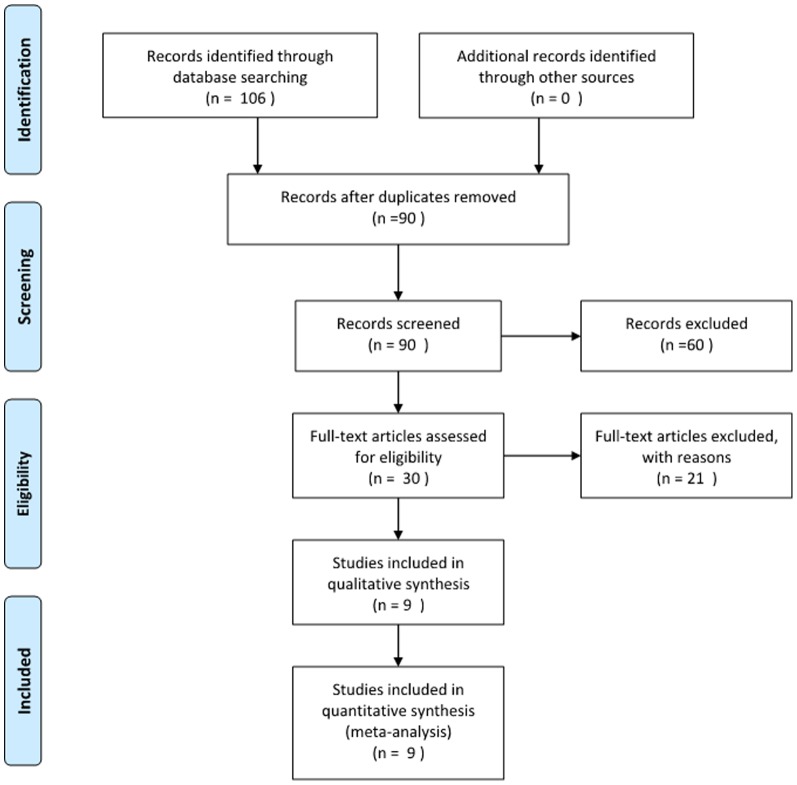
The process of identifying relevant srufies is summarized.